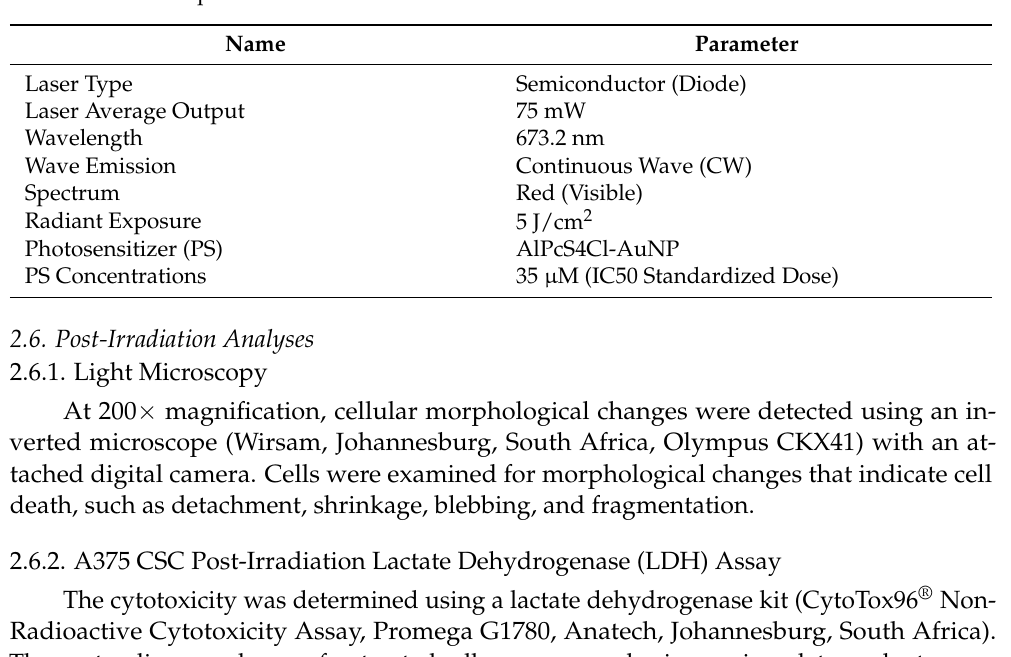
Table 2. PDT laser